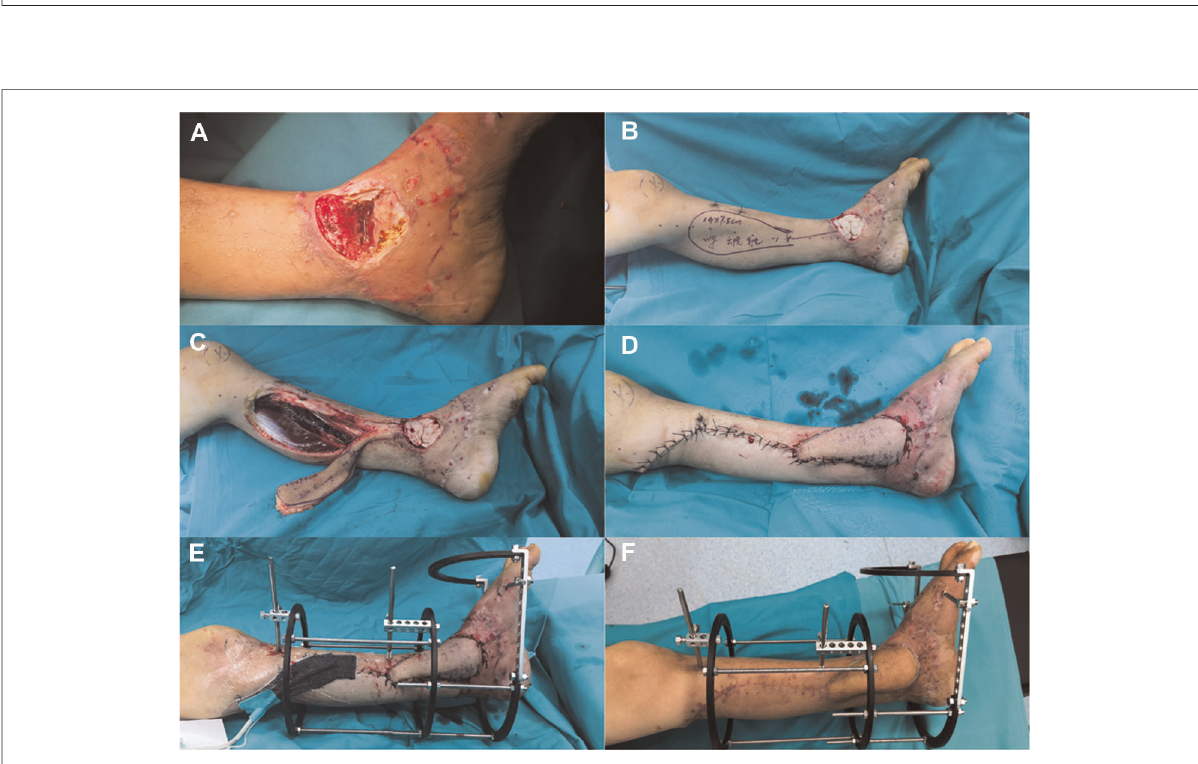
FIGURE 2 ( A ) Granulation tissue and a 3.6-cm bone defect after thorough debridement and VSD. ( B ) In the fi rst stage, the tibial and talar bone defects were fi lled with antibiotic-loaded bone cement. ( C ) A distally based saphenous neurocutaneous perforator fl ap (size, 14×7.5 cm 2 ) was designed on the patient's left calf. ( D ) Soft tissue defects were covered appropriately. ( E ) The bone was stabilized with an external fi xator that bridged the ankle joint. ( F ) The fl ap totally survived for 5 weeks after the fi rst